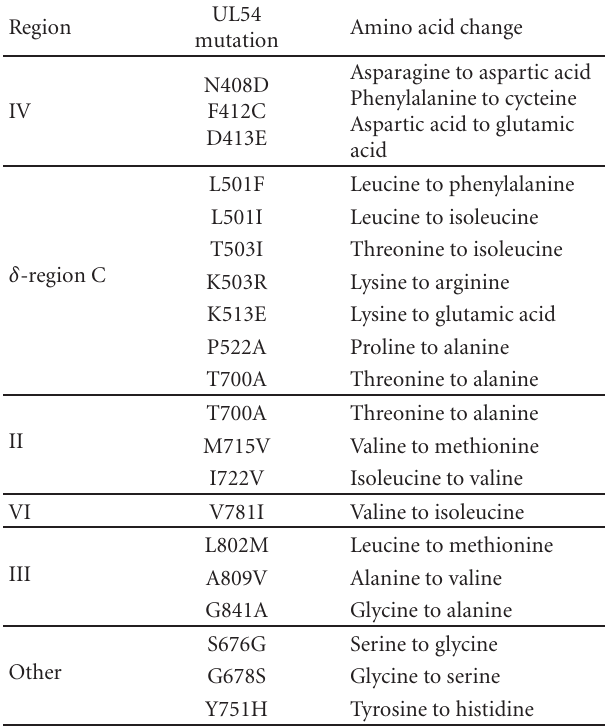
Table 2: UL54 mutations in clinical CMV isolates resistant to GCV